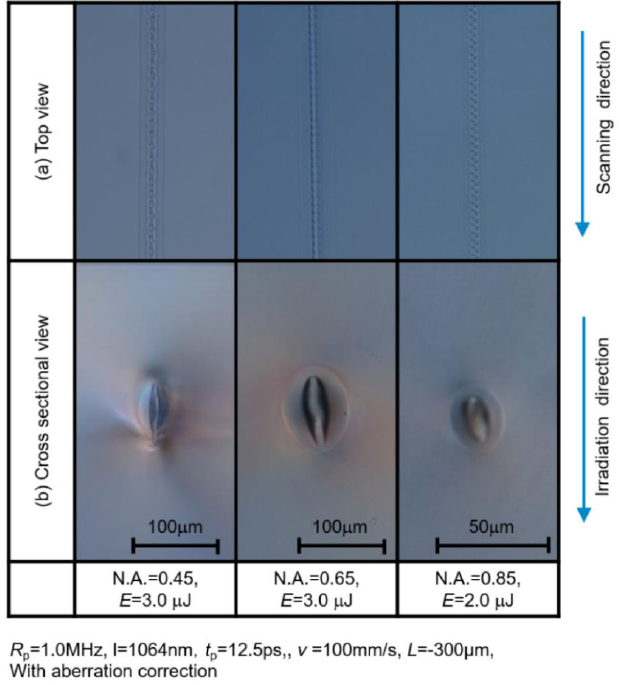
Figure 14. Top and cross sectional views of molten area for various numerical apertures.